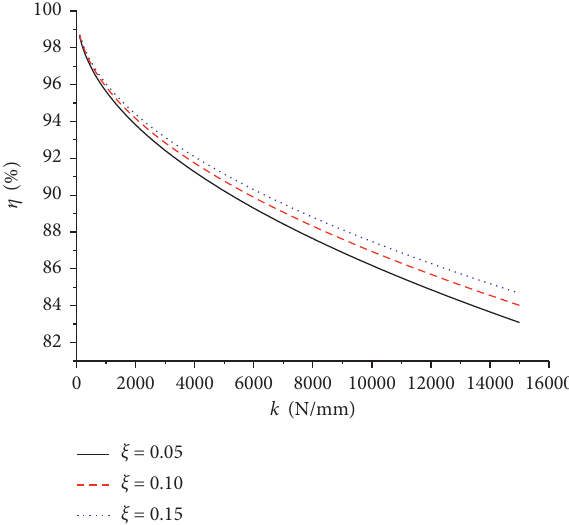
Figure 12: Vibration isolation rate curve of isolation device with changing stiffness.